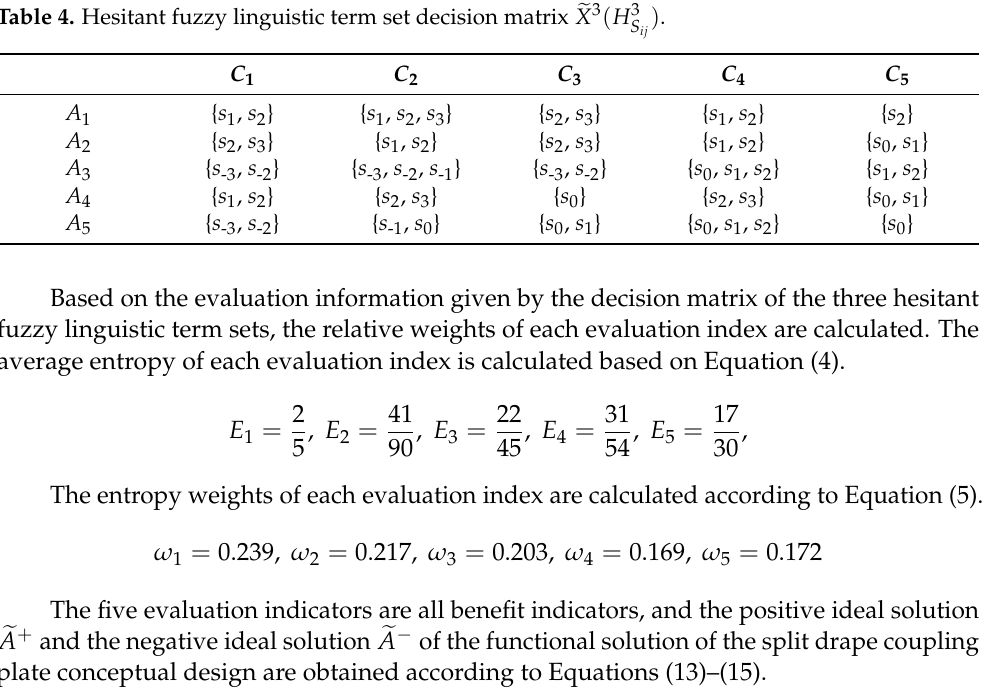
Very Good Between poor and medium Between good and very good Between poor and medium